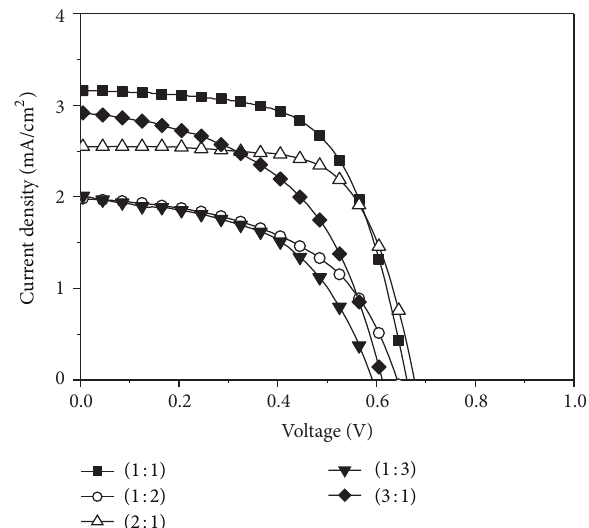
Figure6: J-V curvesofDSSCssensitizedbycocktaildyesatdifferent volume ratios.